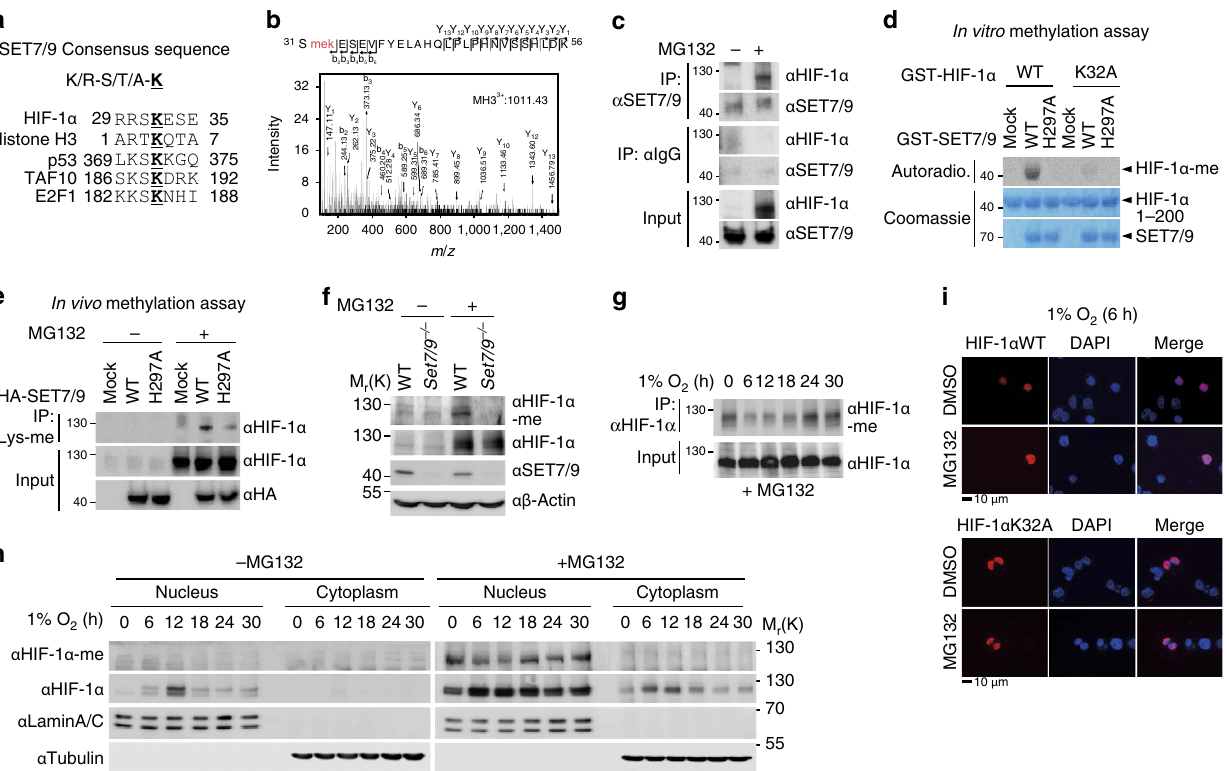
Figure 1 | Identification of HIF-1 a methylation by SET7/9 methyltransferase at the K32 residue. ( a ) Identification of a putative SET7/9 methylation site in HIF-1 a . ( b ) Mass spectrometric analysis of HIF-1 a purified from HeLa cells indicates HIF-1 a methylation at the K32 residue. ( c ) Co-immunoprecipitation of endogenous HIF-1 a with SET7/9 from HeLa cells treated with or without MG132. ( d ) In vitro methylation assay of HIF-1 a WT or K32A proteins was performed with either purified SET7/9 WT or enzymatic MT (H297A) proteins. ( e ) HIF-1 a methylation was determined in HeLa cells expressing either SET9 WTor H297A MT. Immunoprecipitation assay with anti-methyl lysine antibody, followed by immunoblot (IB) analysis with anti-HIF-1 a antibody was performed. ( f ) HIF-1 a methylation level was determined in WT or Set7/9 (cid:2) / (cid:2) MEFs treated with or without MG132. ( g ) Immunoprecipitation with anti-HIF-1 a antibody from HeLa cells treated with MG132, followed by IB analysis with anti-HIF-1 a -me antibody. ( h ) Nuclear and cytoplasmic fractionation of HeLa cells was performed and methylated HIF-1 a levels were monitored. HeLa cells were exposed to hypoxic conditions with or without MG132 for the indicated times. Lamin A/C was used as a nuclear marker and tubulin was used as a cytoplasmic marker. ( i ) HeLa cells were transfected with Flag-HIF-1 a WTor K32A MT in the presence or absence of MG132 under hypoxic condition. Cells were stained with anti-Flag antibody (red) as indicated. The